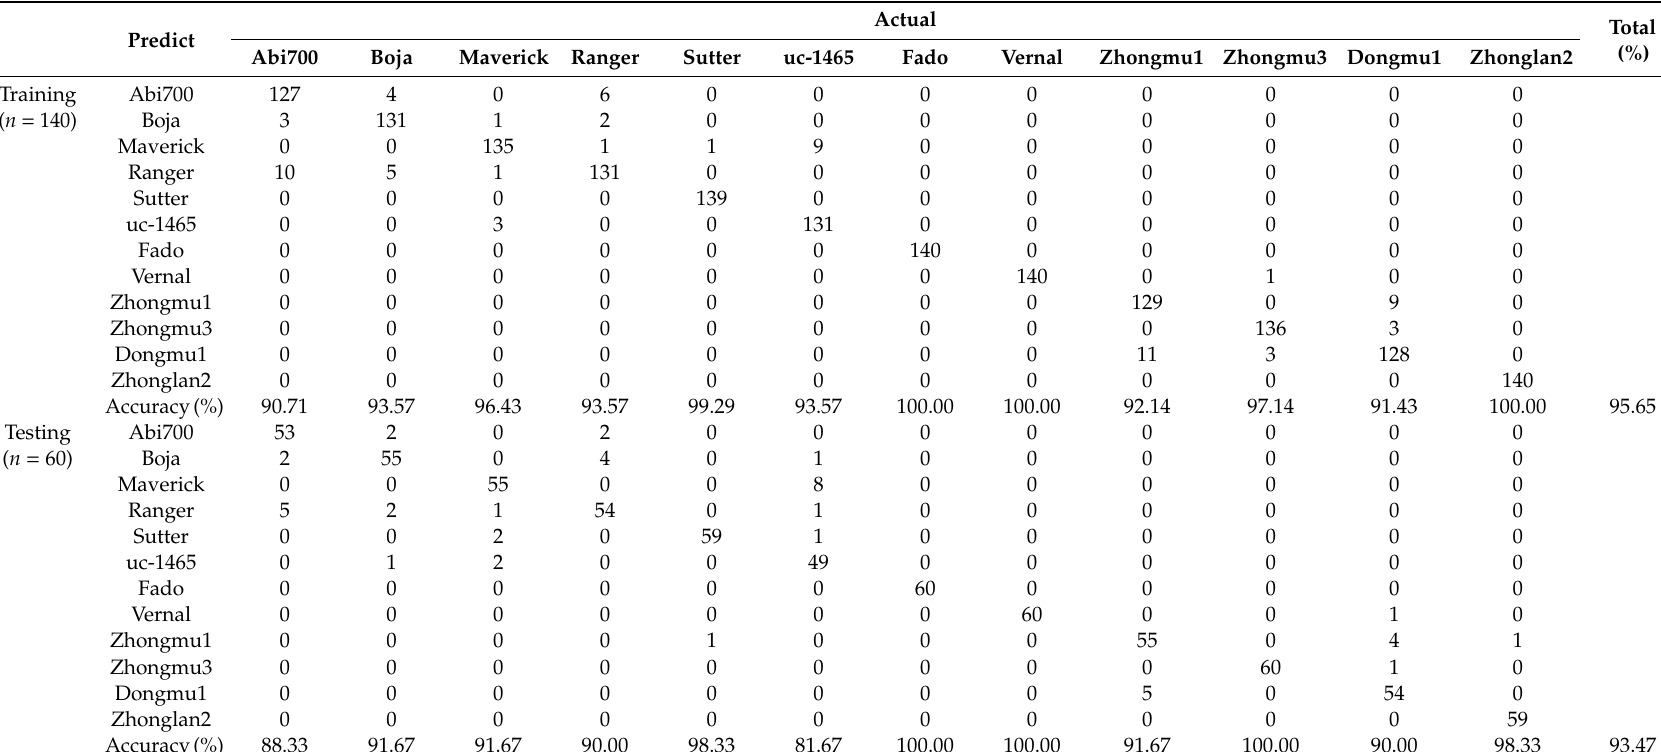
Table 4. Discrimination performance based on SVM with morphology and spectral features of 12 Medicago sativa L.